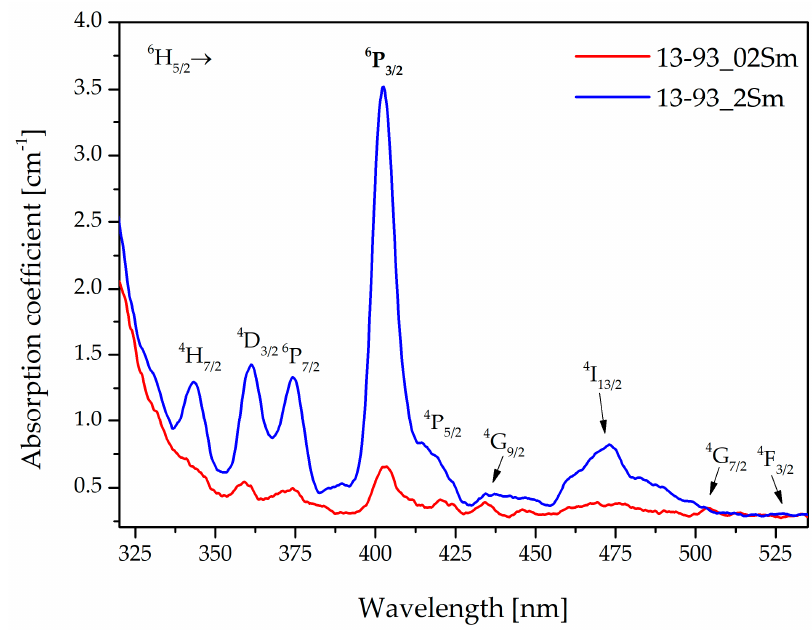
Figure 2. Absorption coefficient spectra of 13 ‐ 93_02Sm and 13 ‐ 93_2Sm.